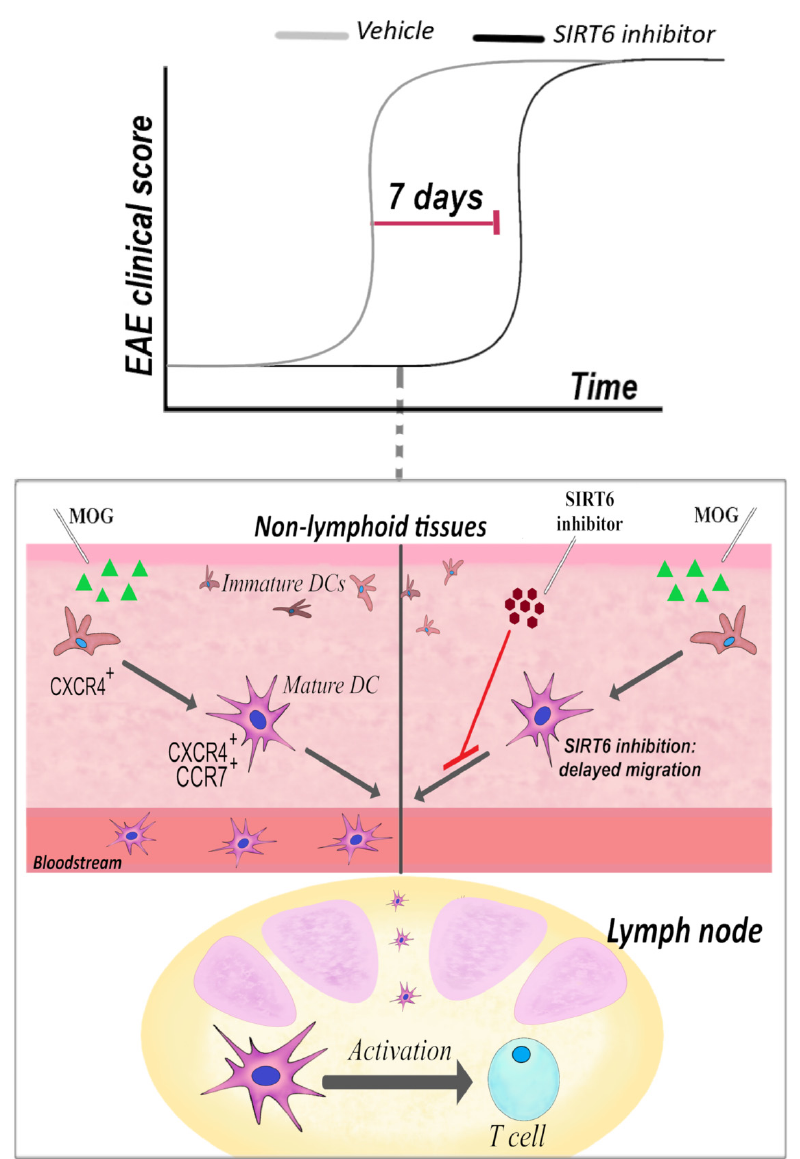
Figure 1. Sirt6 inhibition delays EAE onset by reducing DC migration. In a “preventive” treatment, a SIRT6 inhibitor, named 1, was administered intraperitoneally (30 mg/kg, once/day) at 3 days post-immunization: the clinical score reveals that disease onset was greatly delayed. The representation of CXCR4 + and CXCR4 + /CCR7 + DCs in lymph nodes was greatly reduced [184].